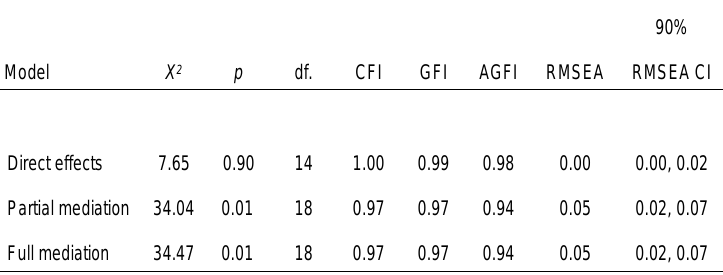
Table 3: Fit indices for each mediation model test (religiosity as mediator)